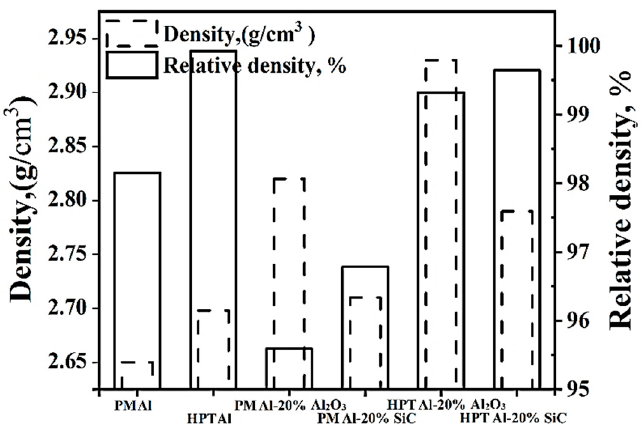
Figure 3. The Experimental and relative densities of the different samples.